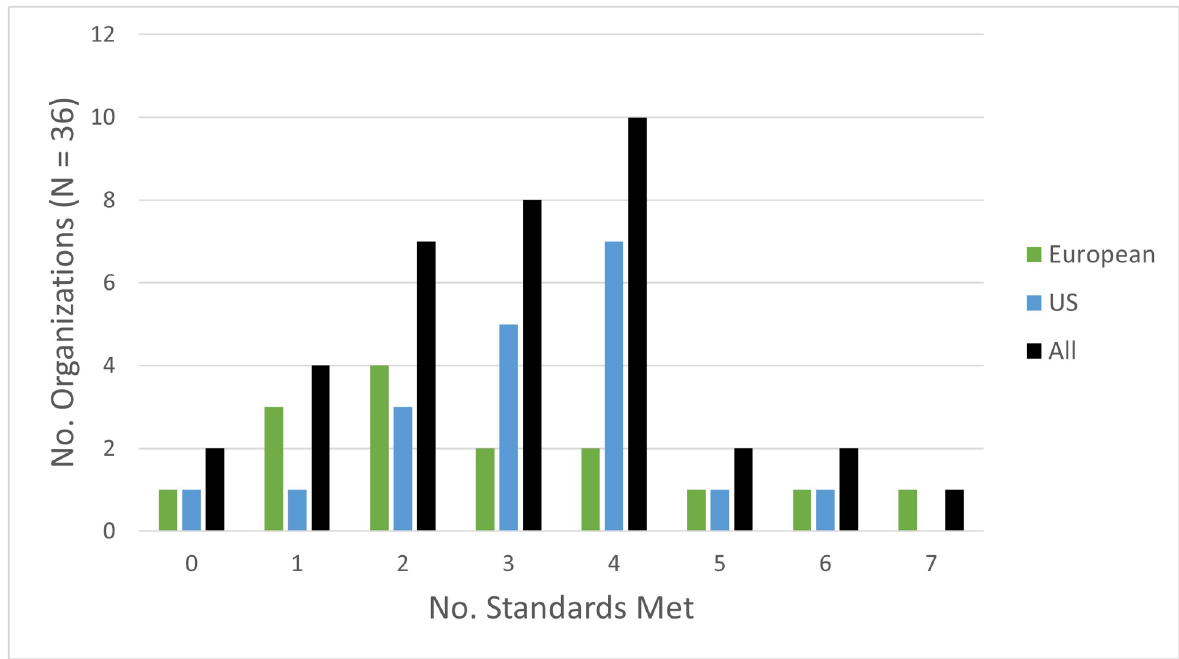
Fig 1. Number of IOM standards by organizations. The number of organizations (y-axis) that meet a total of x standards (x-axis) are shown. For each x number of standards met, results are stratified per the legend to show the number of organizations from Europe, the US, or everywhere (i.e. All organizations) meeting x standards.